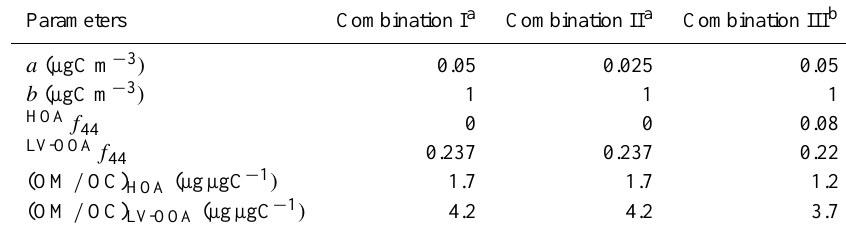
Table 3. Three different combinations of model parameters.